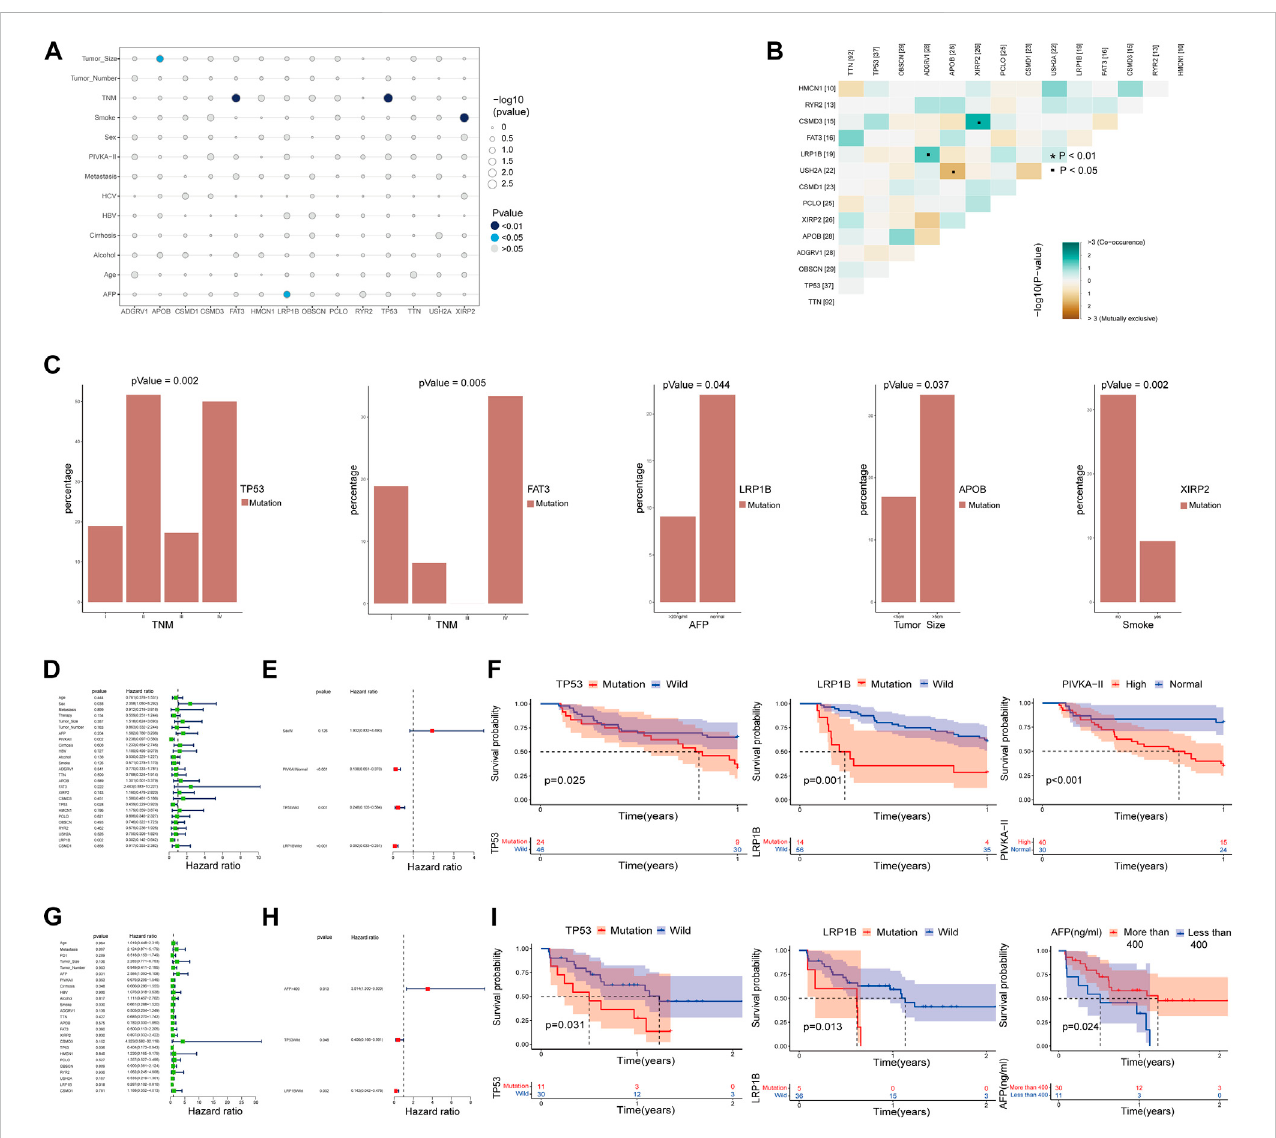
FIGURE 2 Correlation analysis of signi fi cant mutant genes with major clinical features and prognosis. (A – C) Correlation analysis of major mutant genes with major clinical features. (B) Coexistence and mutual exclusion among major mutant genes. (D,E) Univariate and multivariate COX regression analysis of the main in fl uencingfactorsandprogression-freesurvival(PFS)withinoneyearinHCCpatientswithTNMIandTNMII. (F) Theindependentin fl uencingfactorsof1-year progression-free survival (PFS) in HCC patients with TNMI and TNMII were analyzed by K-M survival curve. (G,H) Univariate and multivariate COX regressionanalysis of the main in fl uencing factors and overallsurvival (OS) in HCC patients with TNMIIIand TNMIV. (I) The independentin fl uencing factors of overall survival (OS) in HCC patients with TNMIII and TNMIV were analyzed by Kaplan-Meier survival